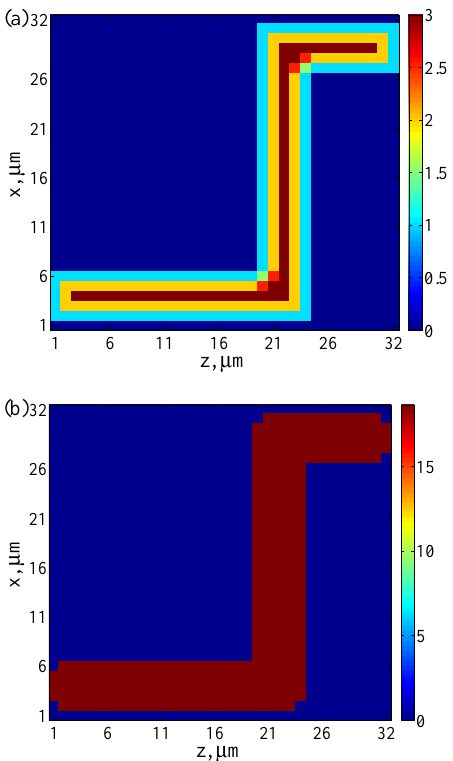
Figure 17. ( a ) Distribution of d for a one-cell-thick layer of model four. ( b ) Distribution of w for a one-cell-thick layer of model four.